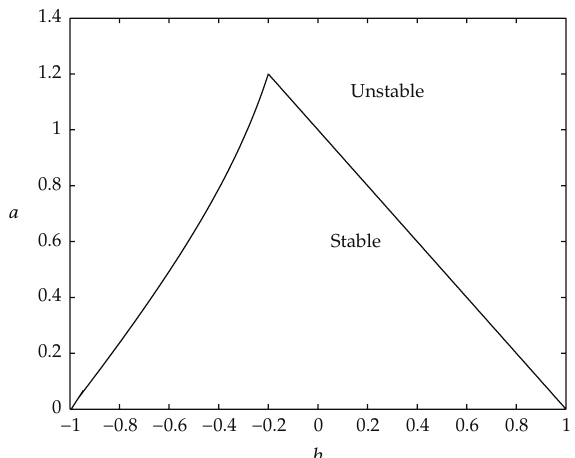
Figure 1: The domain of asymptotic stability of (cid:5) 1.2 (cid:8) , a